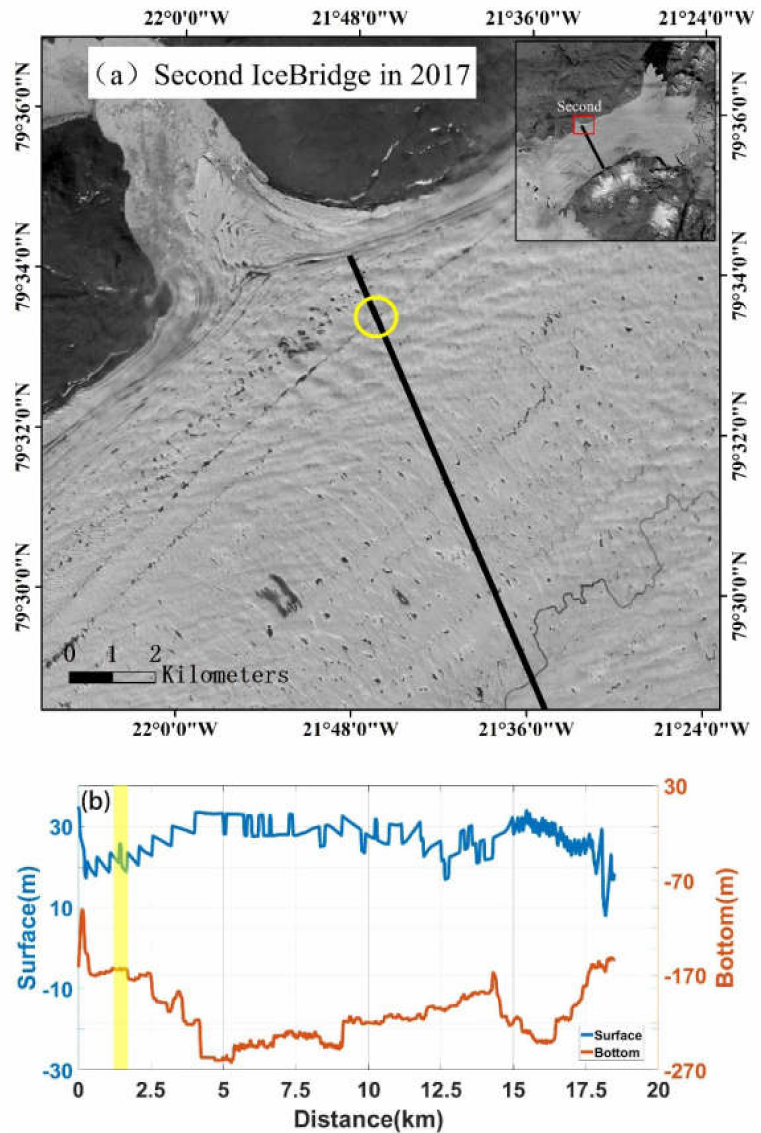
Figure A4. The second IceBridge in 2017 validates the data and Landsat imagery. ( a ) shows the surface morphology at the second IceBridge data in 2017, with IceBridge airborne radar flight path (black solid line). The location indicated by the yellow circle is the area confirming the existence of the basal channel. ( b ) shows the results from the second IceBridge in 2017. The yellow area corresponds to the yellow circle in ( a